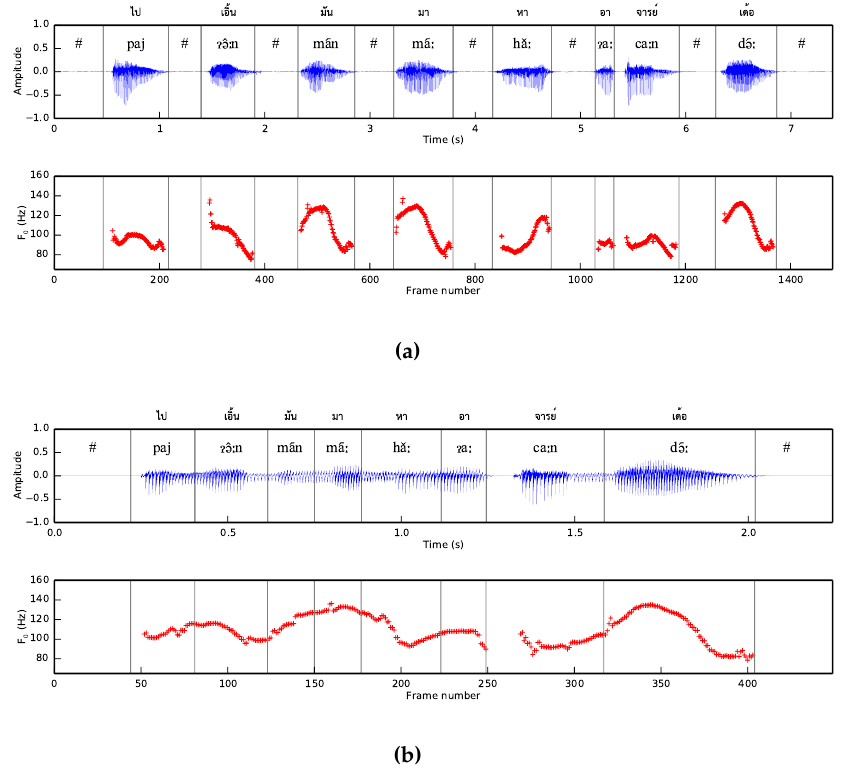
Figure 2. Comparison of F 0 contours of the Isarn utterance (“Please call him to meet the teacher.” in English translation) pronounced by the same speaker in ( a ) isolation and ( b ) continuous